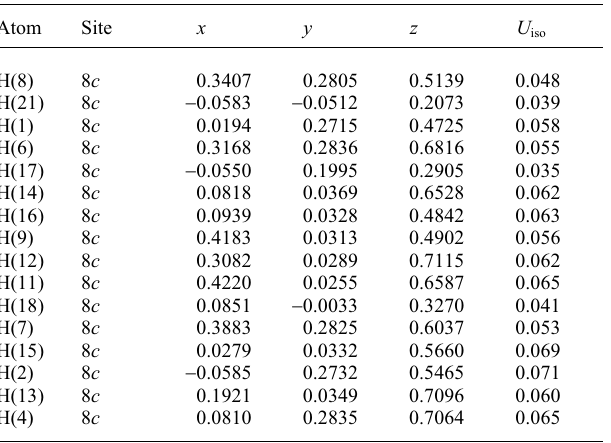
Table 2. Atomic coordinates and displacement parameters (in Å 2 )